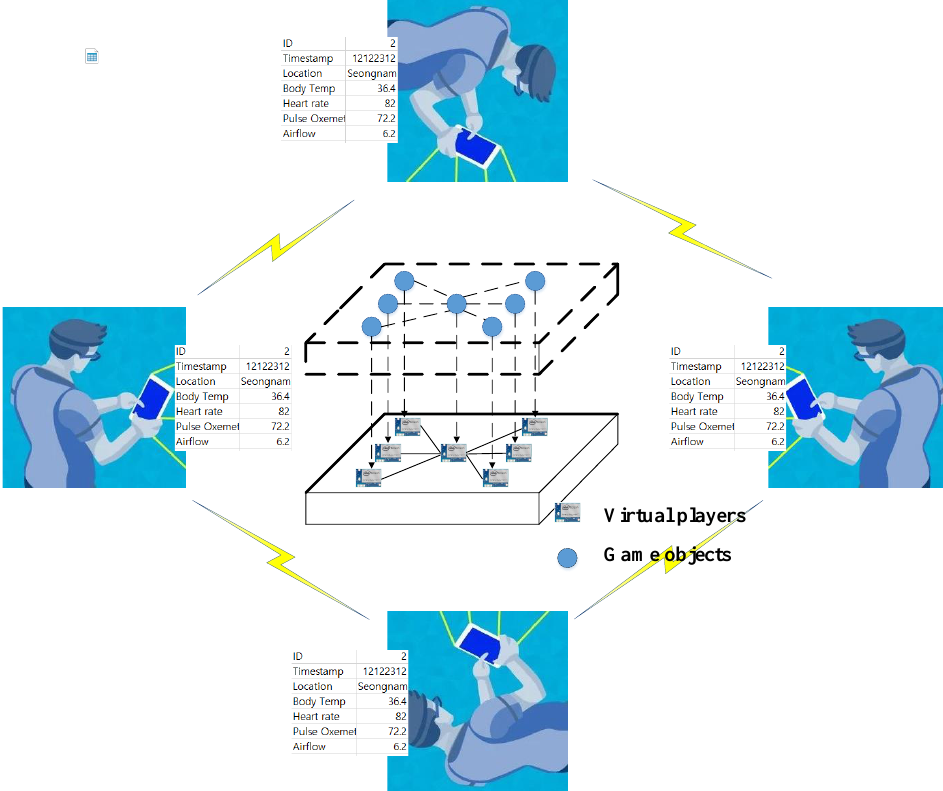
Figure 5. The flow of data between physical space and